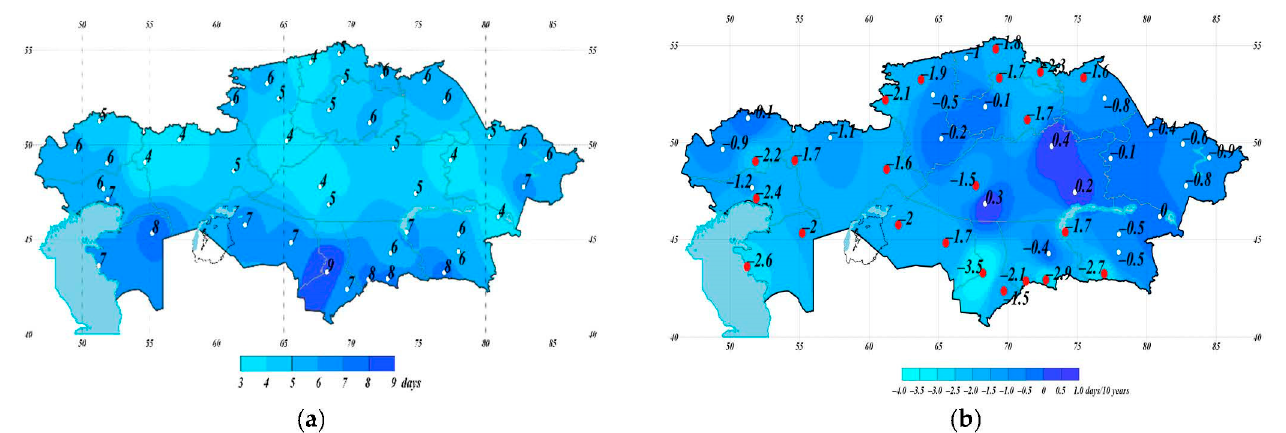
Figure 9. Spatial distribution of the index characterizing the distribution of cold wave duration (CSDI) ( a ) and trends ( b ) of this parameter for the period 1971–2020.